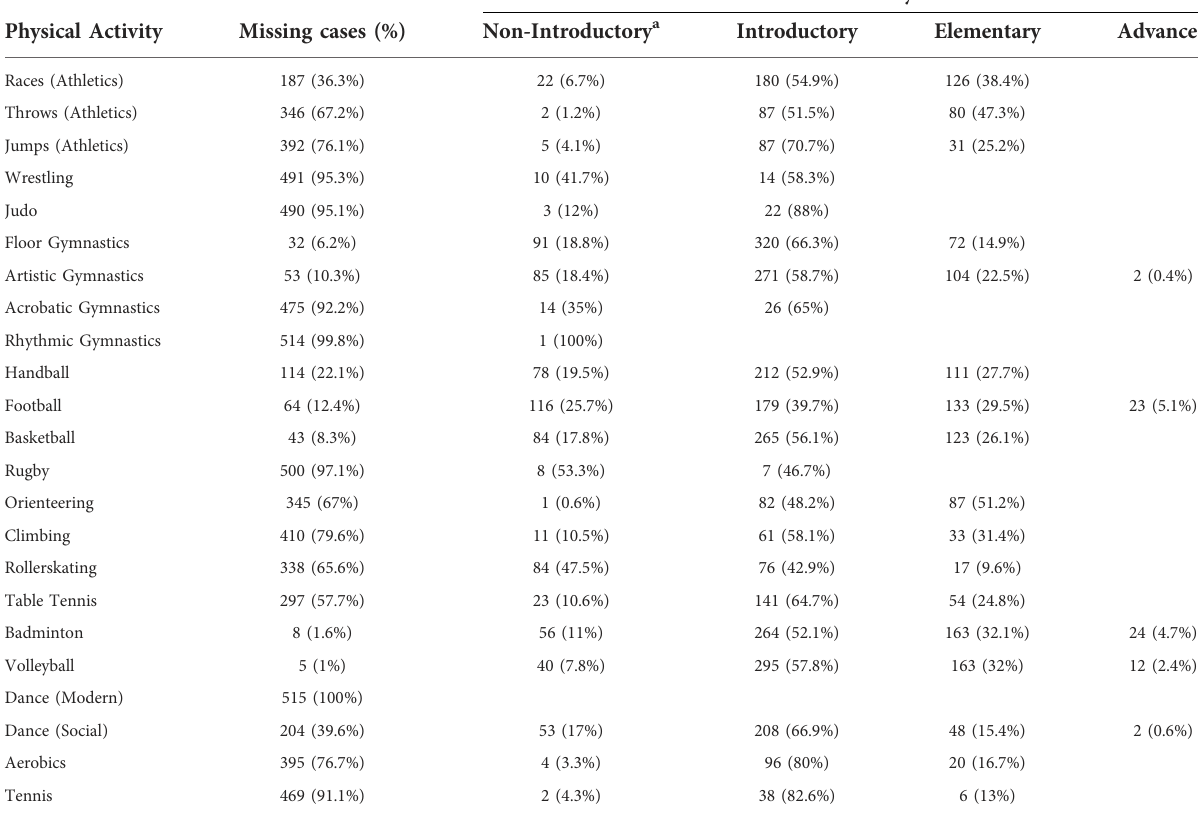
TABLE 4 Descriptive statistics for teacher-reported pro fi ciency levels in physical activities – movement competence, rules, and tactics module ( N =515).